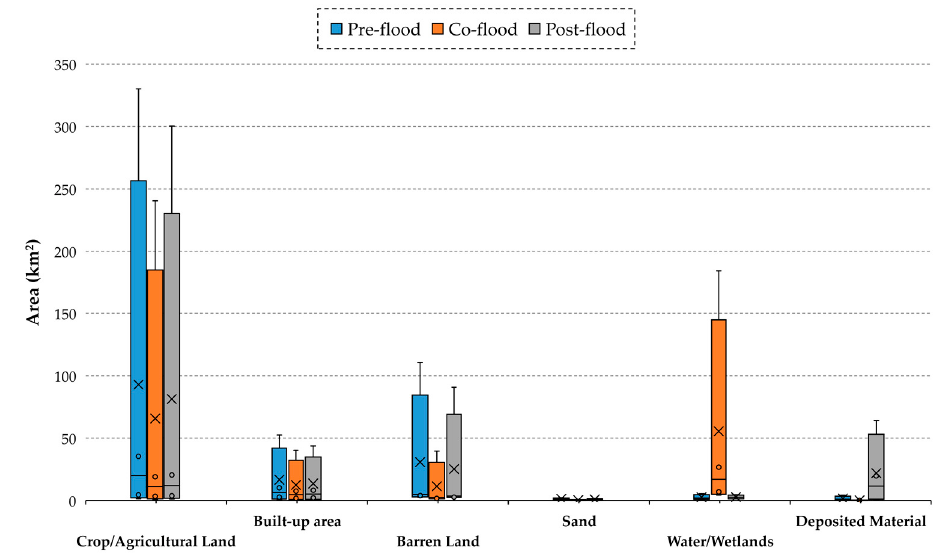
Figure 3. LULC classification of Muzaffargarh District before the flood (left), during (middle), and after (right) the 2014 flood as identified using Landsat images.